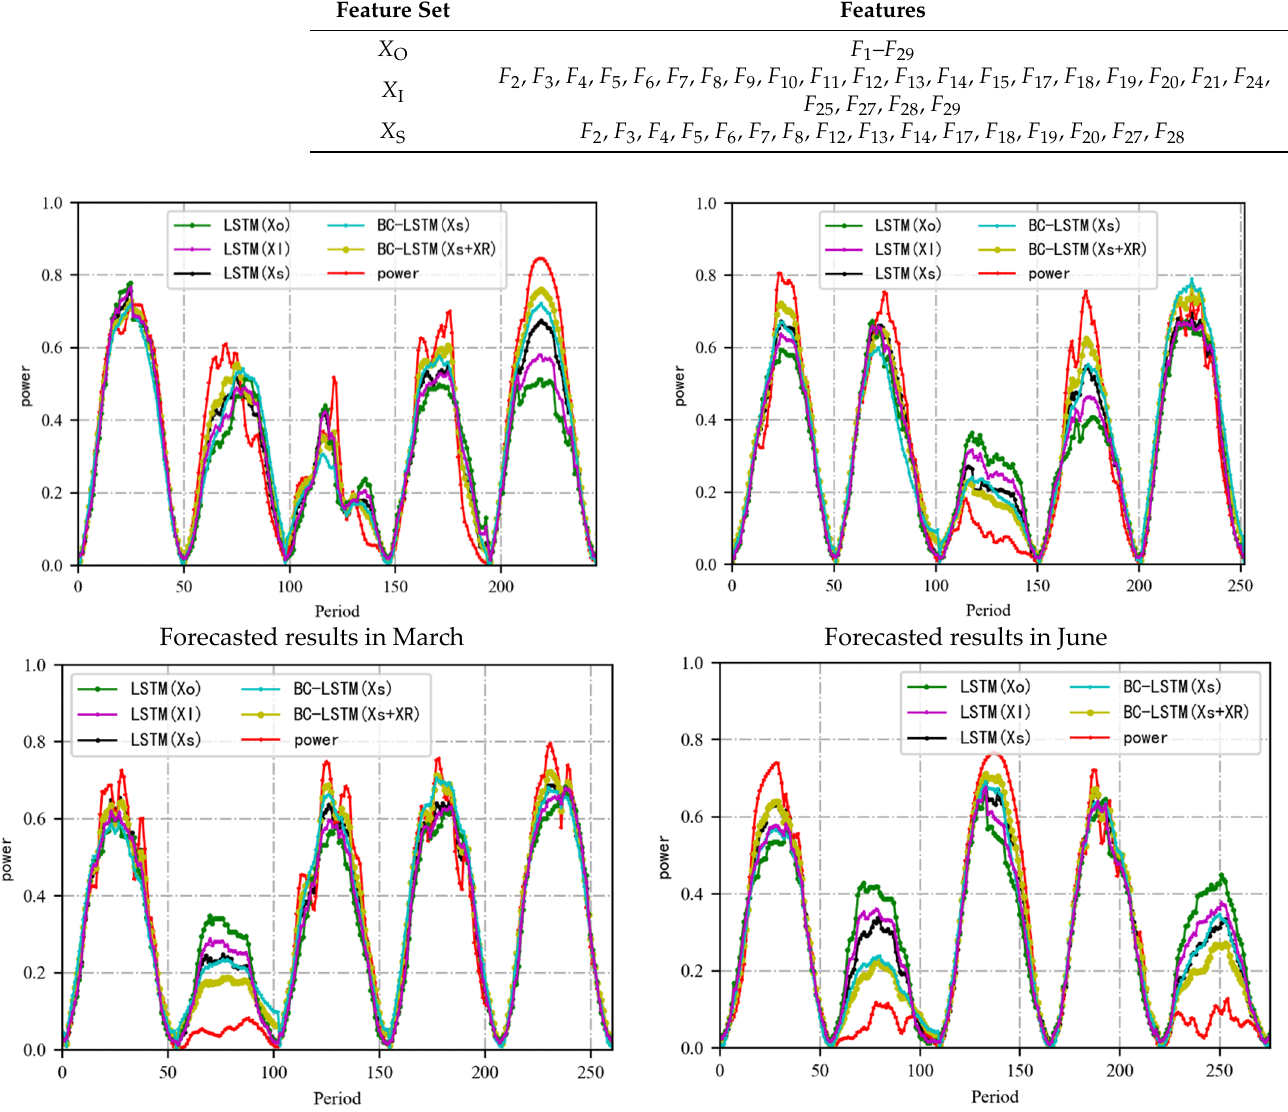
Figure 6. Forecast results: the x-axis represents the period, and the y-axis denotes the normalized power values. The red curve represents the actual power value, and the different curves represent the prediction results of the different models. The best prediction results are given by BC–LSTM ( X s + X R ).